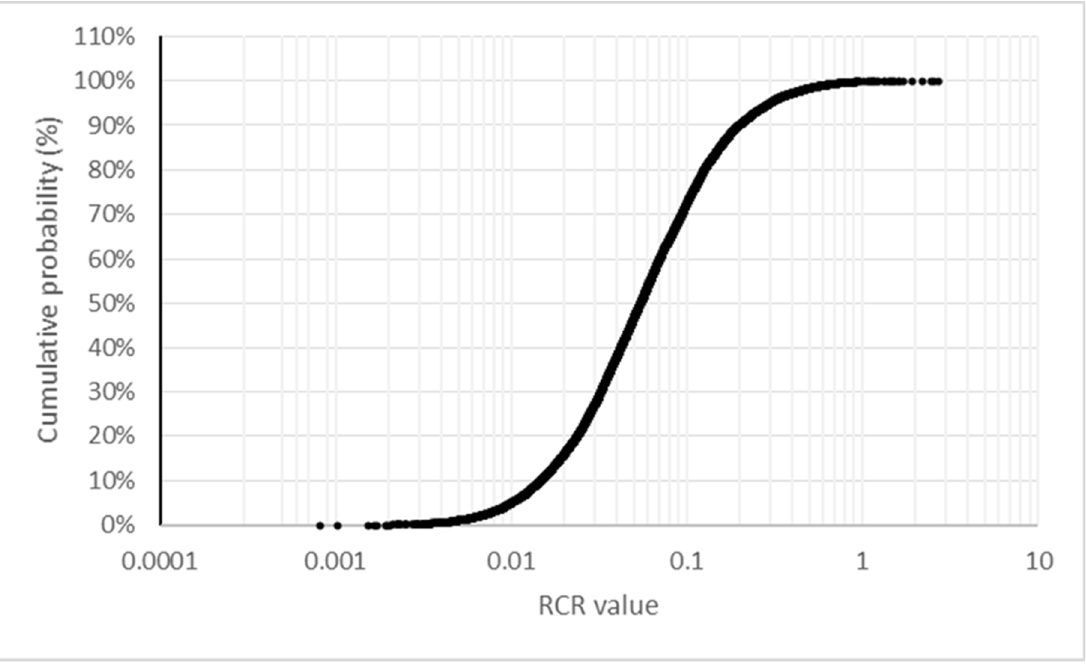
Figure 3. Probabilistic Monte Carlo-based estimation of RCR values for the Belgium children data.